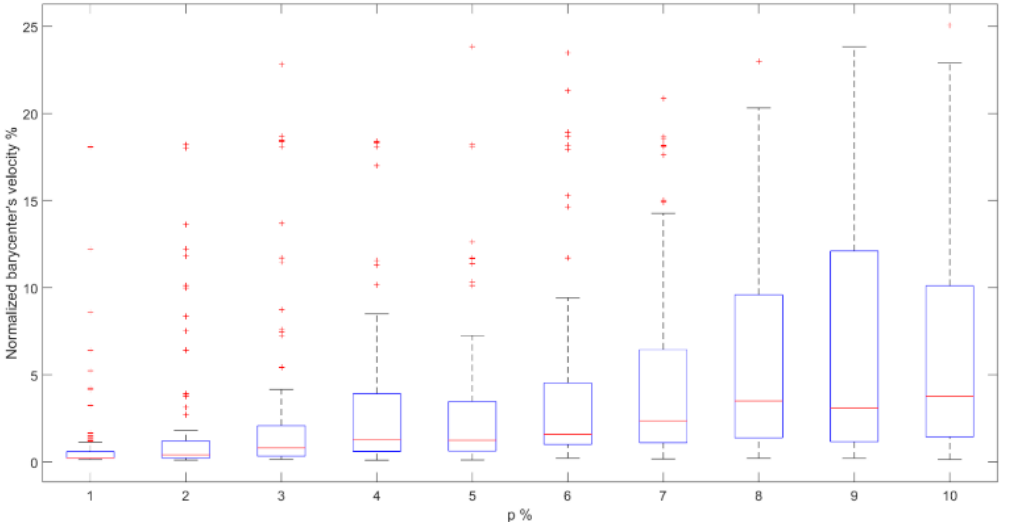
Figure 22. Percentage of samples with nondimensional barycenter’s velocity greater than 10% plotted versus the probability of long-range connection. For low to mid values of P , the median is very close to the first quartile, which means the samples are characterized by lower amplitudes. For the highest values of P , the median gets higher and further form the first quartile, so a collective behavior of the platoon is very likely to be observed among the vast majority of the samples. For values of P of the order of 6 ÷ 7%, the boxplots get indeed significantly larger, the quartiles not only get farther from one another, but also the median significantly increase its value, as shown in Figure 21: it means that the barycenter’s velocity of most of the small world samples is able to follow the leader’s input. Figure 22 shows that for P > 6% the number of samples that goes beyond TL suddenly grows increases from 10 to 20%.